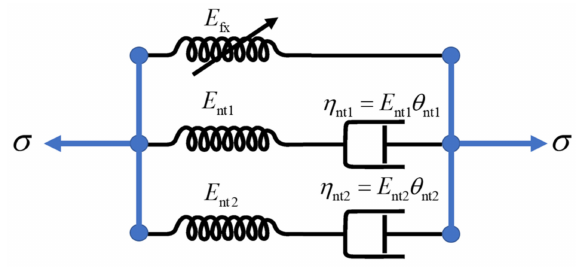
Figure 8. ZWT model.